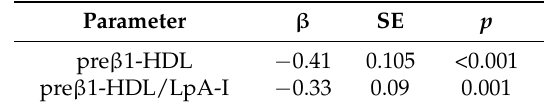
Table 3. Multiple linear regression analysis for the eGFR value *.